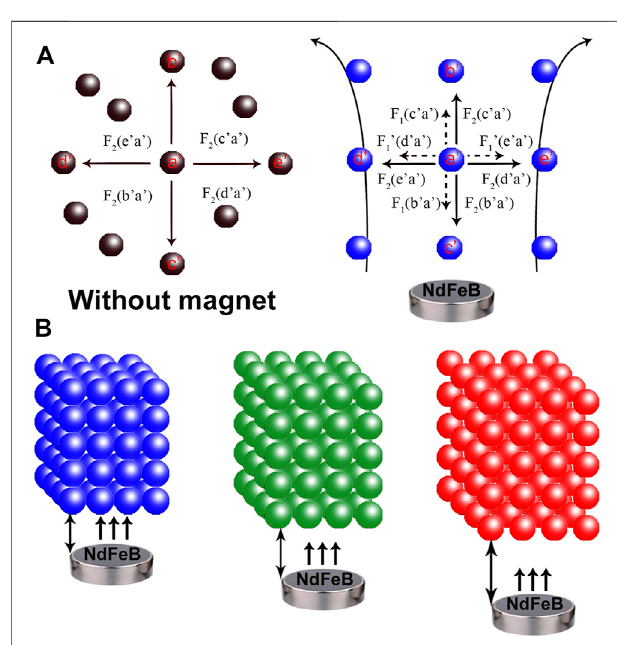
FIGURE 3 | (A) Schematic illustration of the forces on Fe 3 O 4 @C@SiO 2 SMNs in the absence (left) and presence of the EMF (right). F 1 : dipole-dipole attractive force (the small dotted arrow), F 1 ′ : dipole-dipole repulsive force (the small dotted arrow), F 2 : electrostatic repulsive force (the solid arrow). a ′ to e ′ refers to the different directions; and (B) Assembling a 3D orderly array under theEMF. The MRPCs diffraction wascorrespondingly red-shift from left to right as blue, green, and red with the SMNs-magnet distance gradually increased. Reprinted with permission from Liu et al. (2019) Copyright © 2019, Frontiers Media